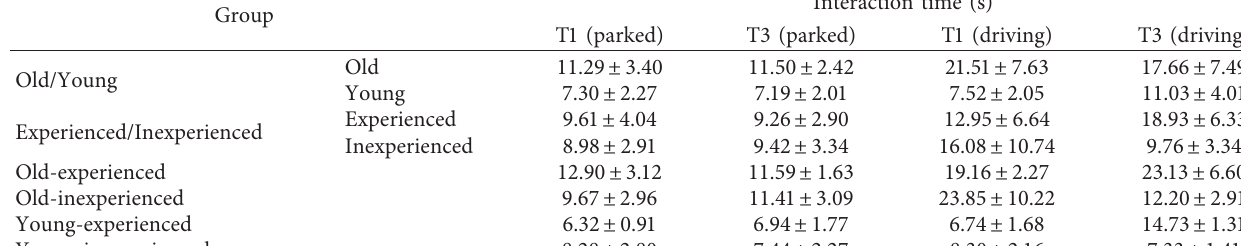
Table 1: Descriptive statistics of mean and standard deviation of interaction time among different ages and experience.